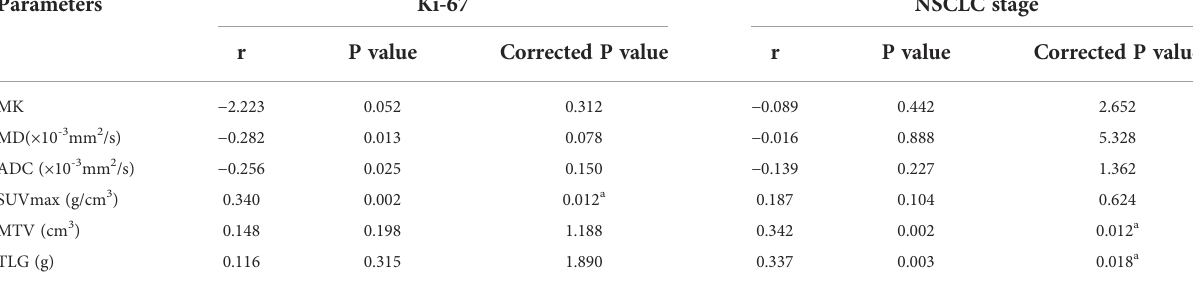
TABLE 6 Correlation of each parameter with Ki-67 and